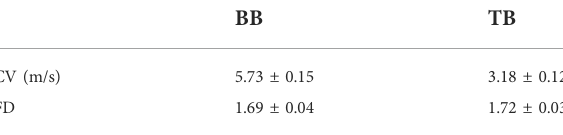
Figure3depictedthechangesinratingofperceivedexertionplotted as a percentage of contraction time during the sustained fatiguing contraction. RPE increased progressively during the whole process of fatiguing contraction and reached 9.54 ± 0.63 at the last 10% contraction duration time. A repeated-measures analysis of variance revealedthatRPEhadasigni fi cantdifferencein10contractionperiods (F = 258.764, p ≤ 0.001). A signi fi cant increasing tendency of the RPE with the change in contraction duration time was found by Pearson cross-correlation analysis ( r = 0.946, p ≤ 0.001). Figure 4 showed the EMG RMS and MF changes of BB and TB muscles during the sustained fatiguing contraction. EMG RMS